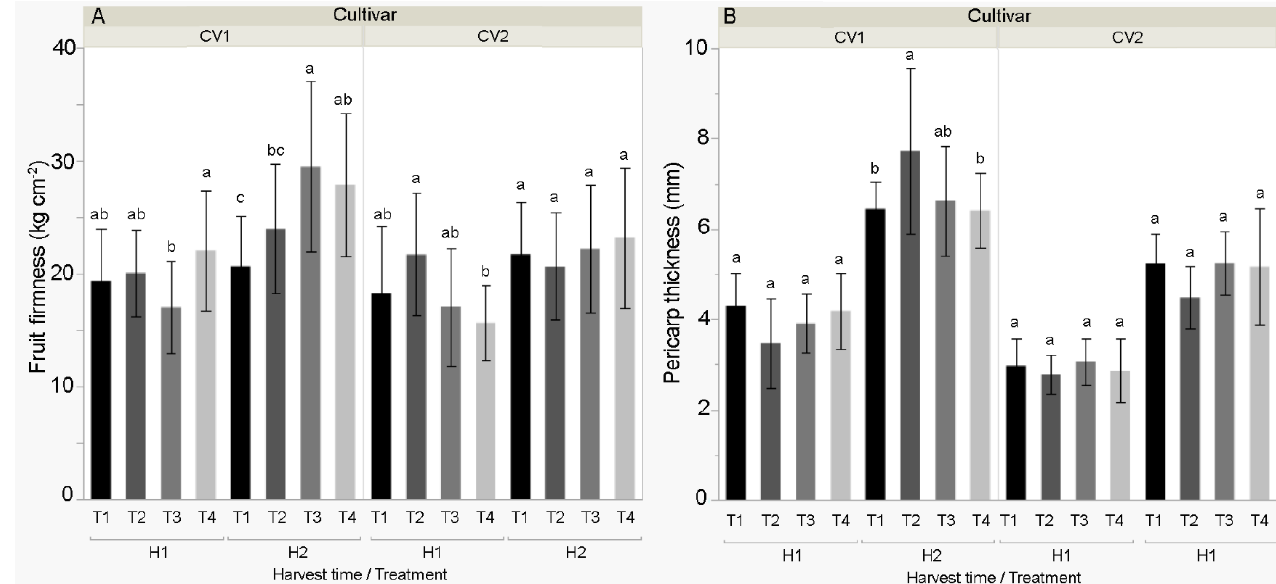
Figure 5. Selected physical fruit properties ( A ) fruit firmness (kg cm −2 ) and ( B ) pericarp thickness (mm) of sweet pepper cultivars CV1 (Šorokšari) and CV2 (Kurtovska kapija) fruits in H1 (first harvest at technological maturity) and H2 (second harvest at physiological maturity). The T1 (control), T2 (Eco Green, calcite nanoparticles at lower concentration), T3 (Eco Green, calcite nanoparticles at higher concentration) and T4 (Zeogreen+P, calcite-based foliar fertilizer) were applied three times during vegetation on sweet pepper plants. Post hoc comparisons of the means were performed using Tukey’s HSD test at p < 0.05; different letters indicate significant differences among treatments within each measurement time.